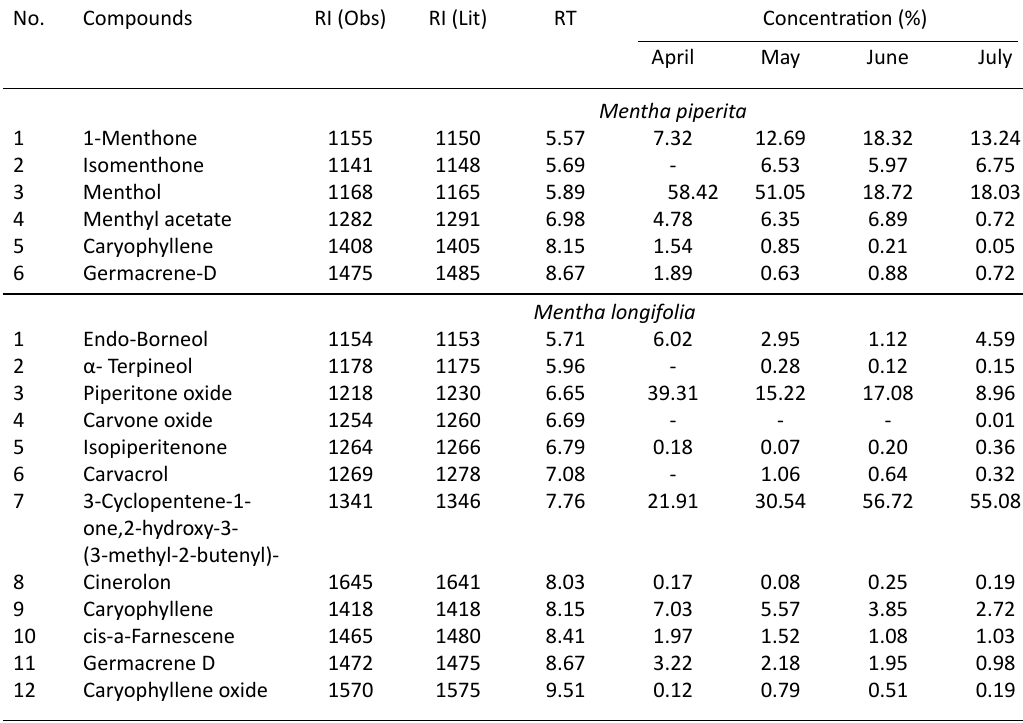
Table 2. Phytocompounds observed in the essential oil from the leaves of M. piperita and M. longifolia (harvested during April-July,